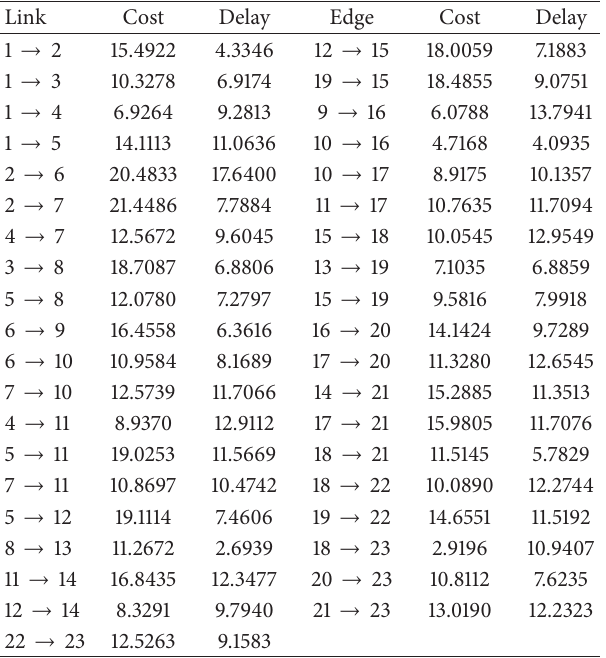
Figure 2: The solution. Table 2: The attributes’ value associated with each